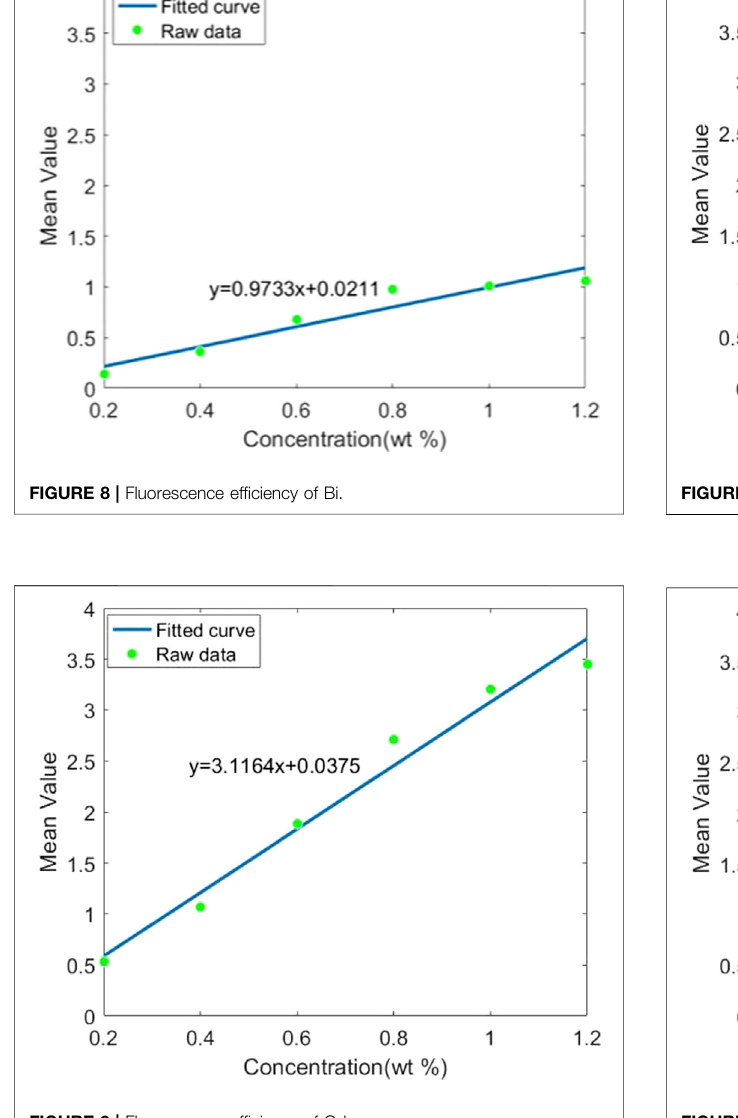
indicates concentration differences badly; for (B) – (D) all perform well, concentration differences are better, the ROI boundary is clear, the internal uniformity is excellent, and the distinction between each ROI is clear; and for (E), the inside of the ROI has poor uniformity and boundary